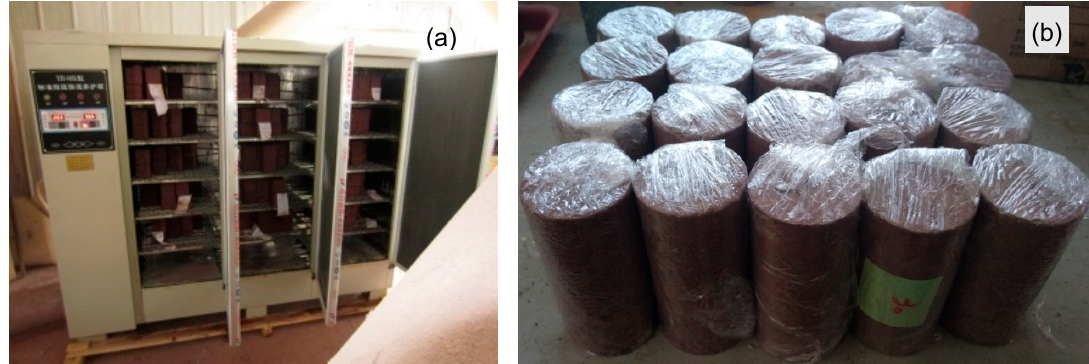
Figure 4. Preparation of the CWRTB samples for the experiment. ( a ) Curing the samples in a humidity chamber; ( b ) CWRTB samples after curing.